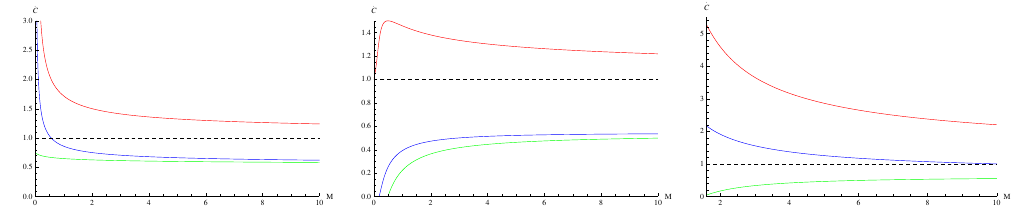
Figure 7 . The growth of the complexity normalized by the Lloyd bound for the planar (left) and spherical black hole (middle and right) is plotted as a function of the black hole mass. The red/blue/green lines correspond to CA/CA-2/CV-2 dualities respectively. We have set q = 1 for the left and middle panels and q = 3 for the right panel. Some other parameters has been chosen as ! 2 = 4 (cid:25) ; G = 1 ; g =